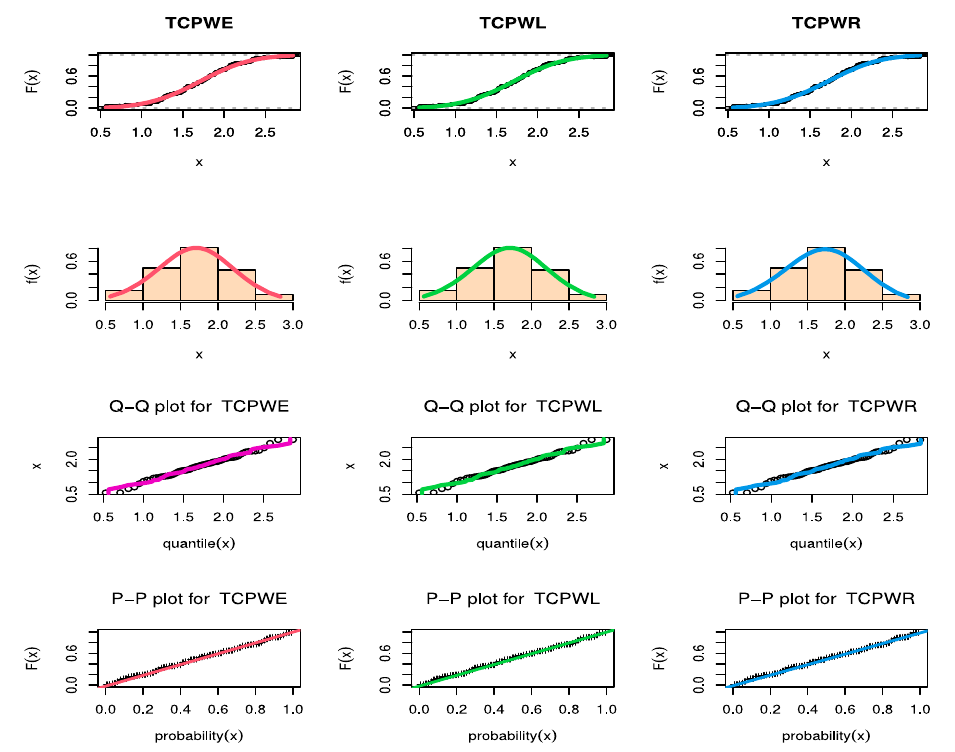
Figure 9. The estimated CDF, fitted PDF, PP-plot, and QQ-plot of the TCPWE and TCPWL and TCPWR distributions for strength data.